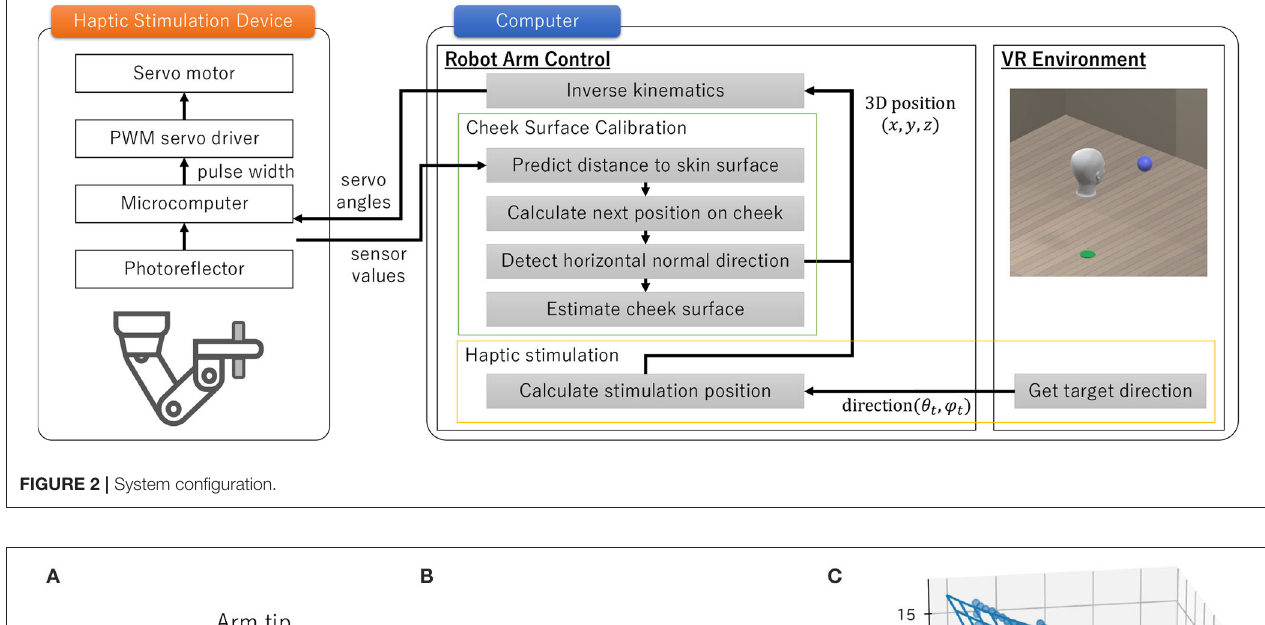
FIGURE 2 | System configuration.